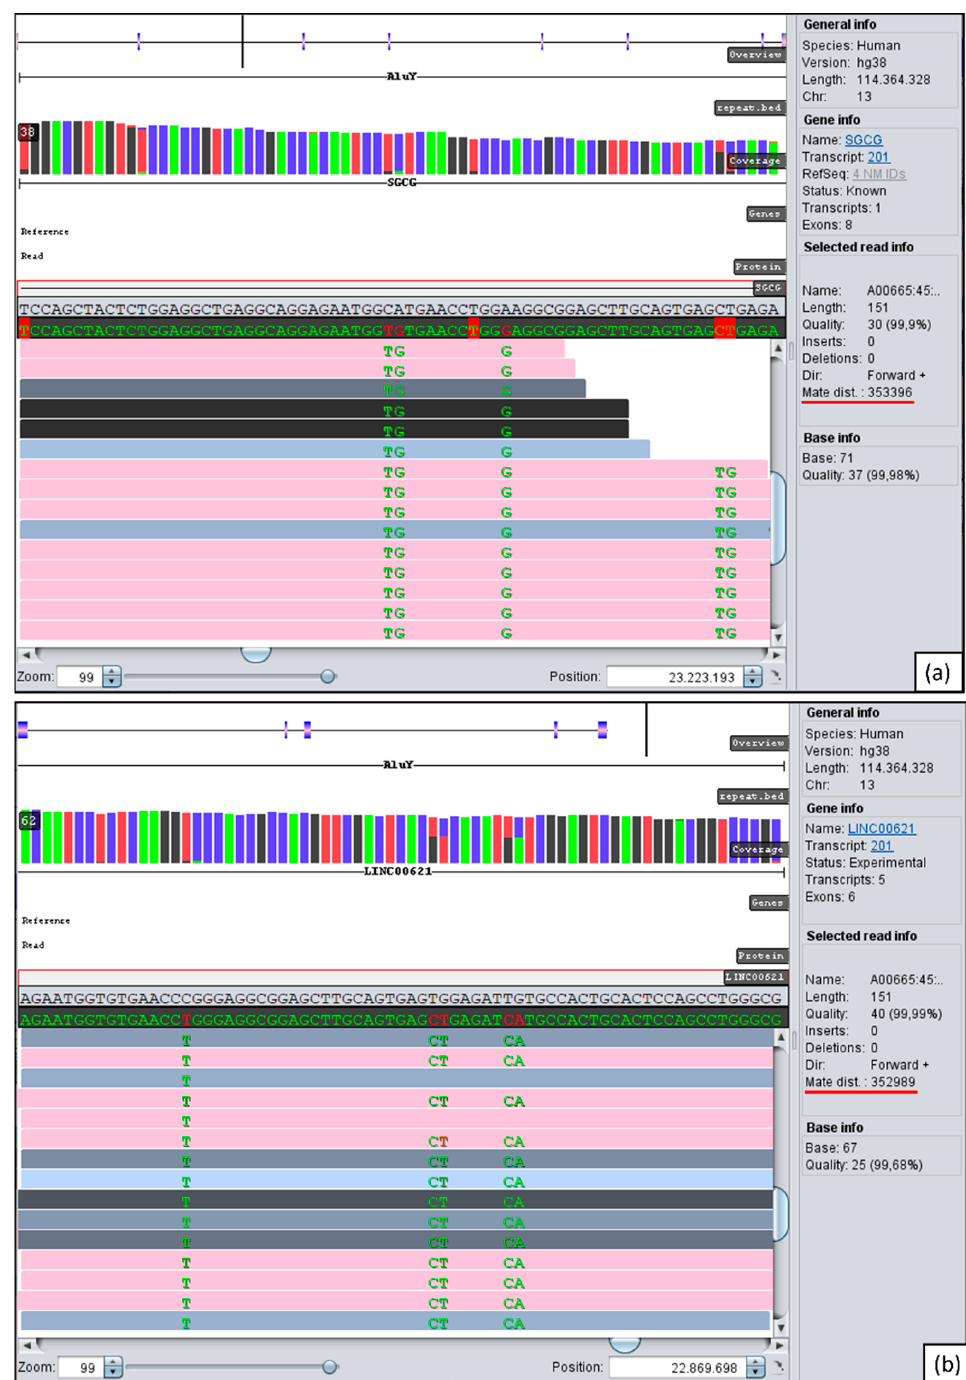
Figure 2. Homozygous area on chromosome 13 of the patient ( above ) and the same region in a control patient ( bottom ) are highlighted in red. In the patient, a plateau at 100% can be seen, which means that in this range all detected variants are present with a frequency of 100% (=homozygous).